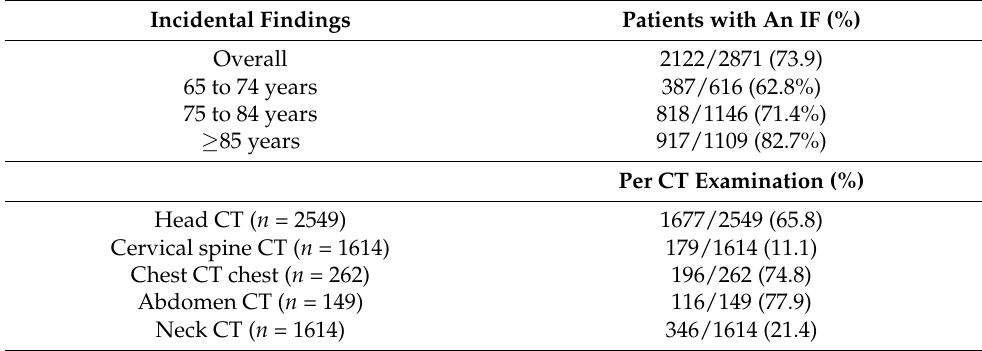
Table 2. Summary of the prevalence of incidental findings per age group and per examination of different body regions (number of examinations).